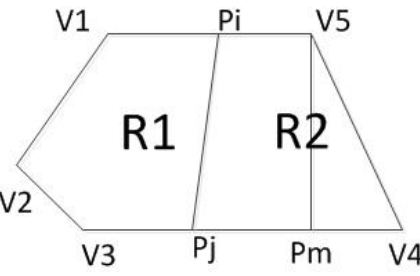
Figure 2. Schematic diagram of the possible